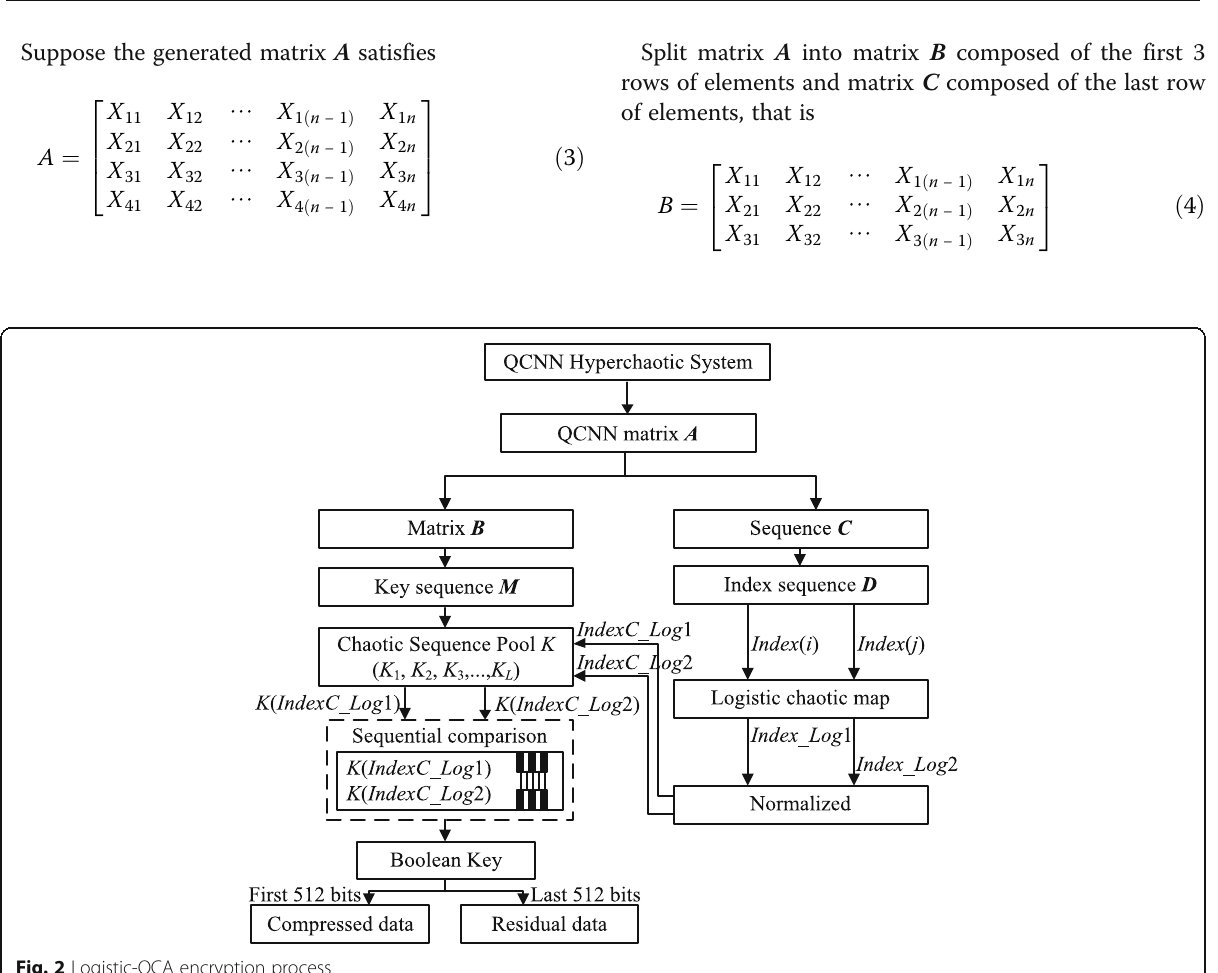
Fig. 1 Video caching and content distribution model in a multi-edge collaborative computing